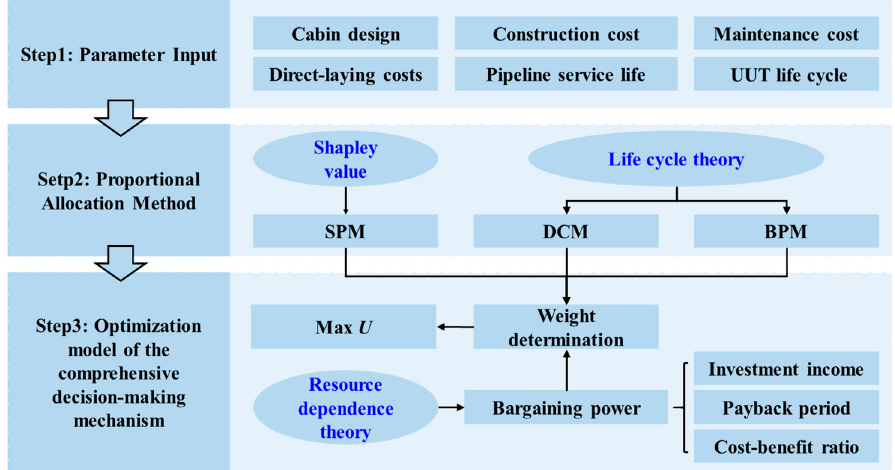
Figure 2. Flow chart of comprehensive decision-making mechanism for UUT construction cost allocation.